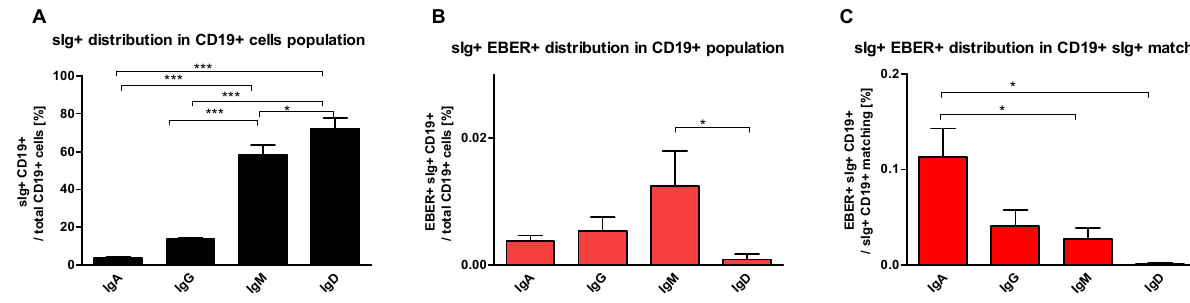
Fig. 2. Differences in surface immunoglobulin expression on CD19 + cells uninfected and infected with EBV.